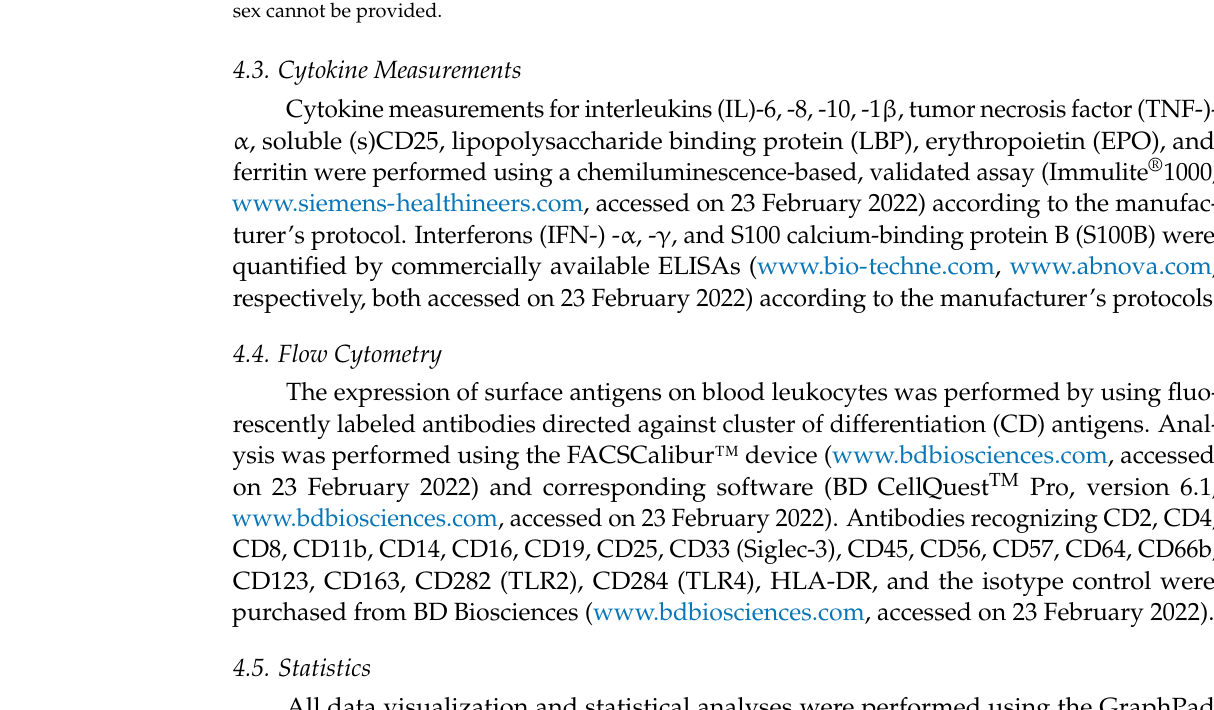
Table S1: Correlation analysis of selected plasma cytokine concentrations in AF, SZ, and HDs, Table S2: Correlation analysis of selected CSF cytokine concentrations in AF, SZ, and